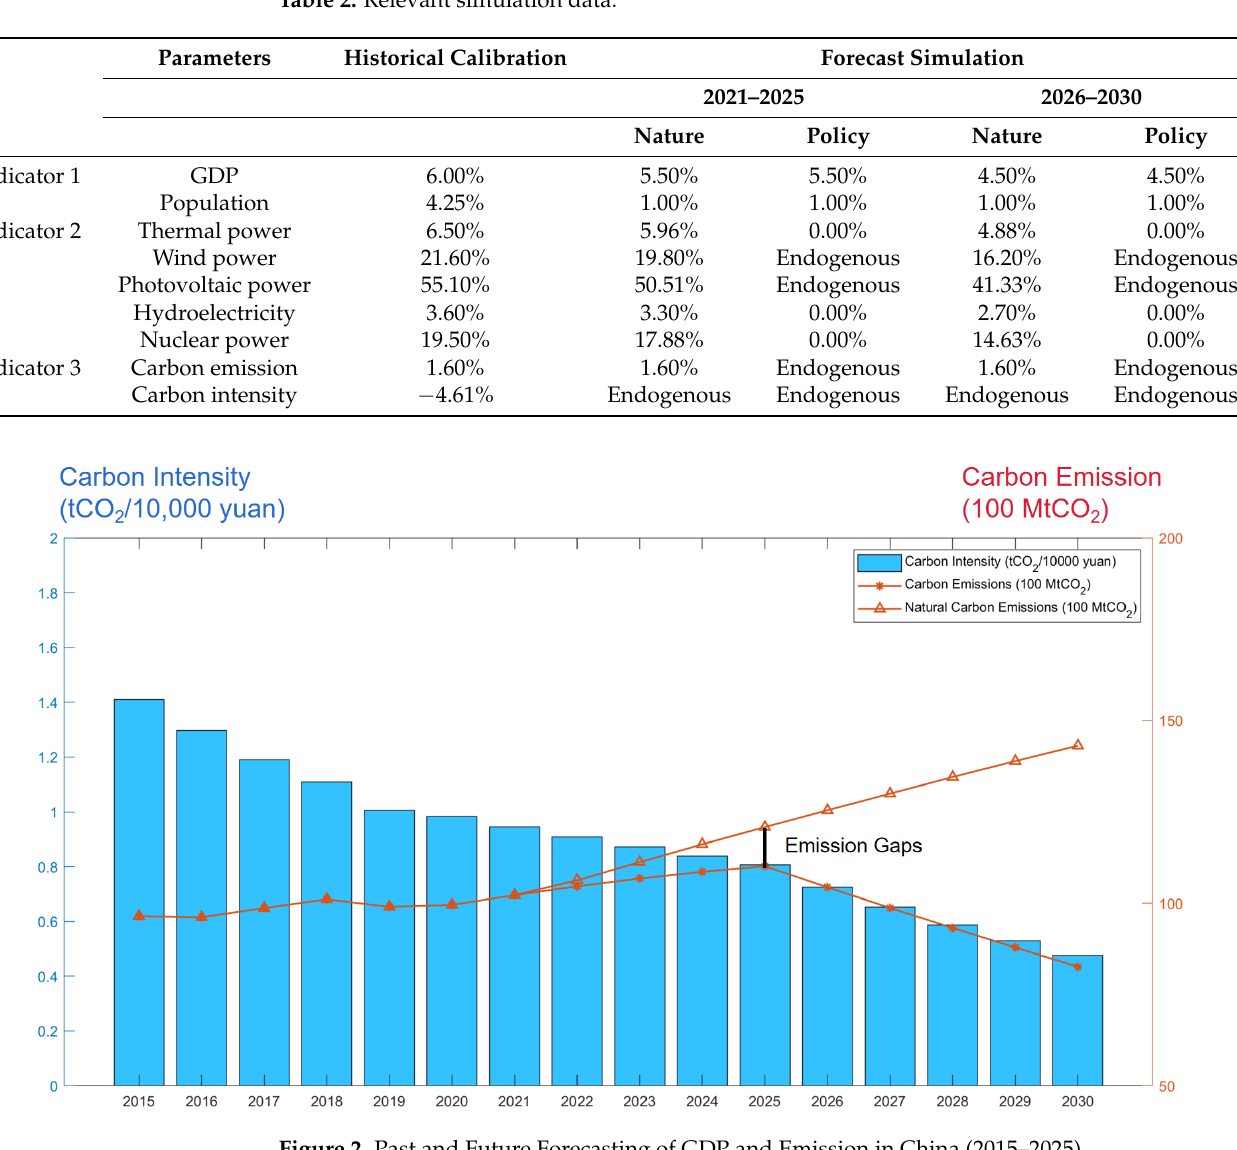
Figure 2. Past and Future Forecasting of GDP and Emission in China (2015–2025).